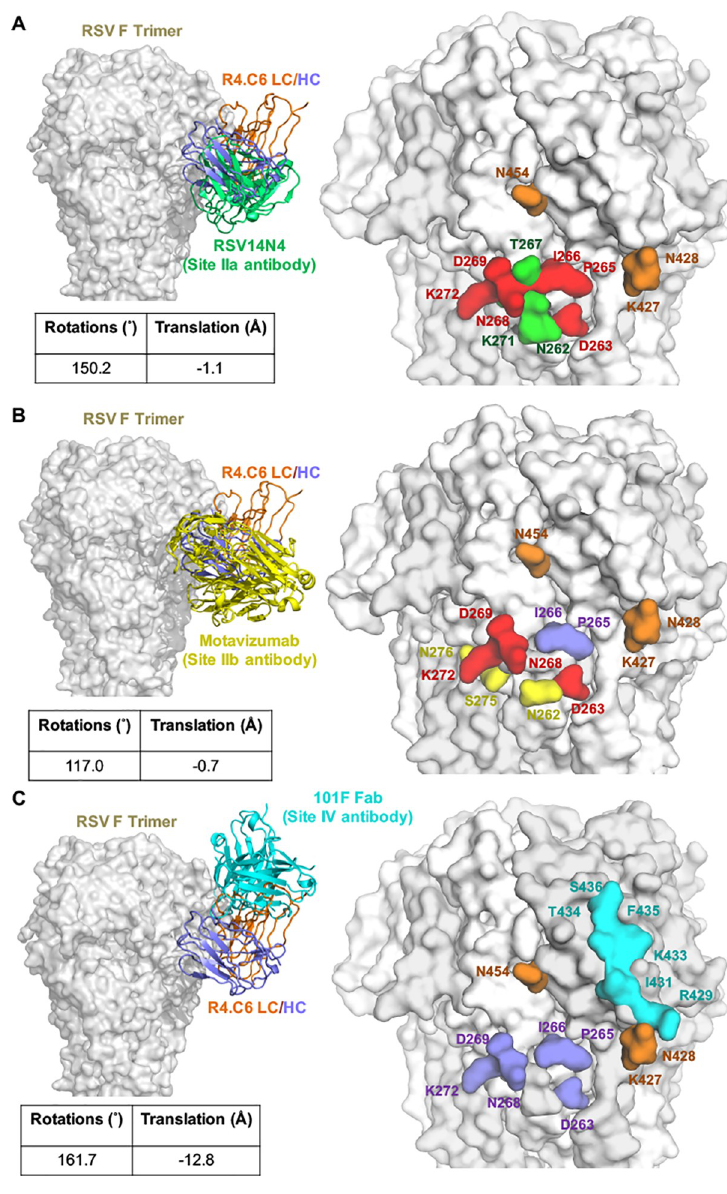
Fig 4. Comparison of known structures of post-fusion RSV F and site II or site IV antibodies. ( A) Comparison of the structure of RSV F-R4.C6 with RSV14N4 bound to site II of RSV F (PDB code 5J3D). Left: RSV F is shown as surface presentation, R4.C6 in ribbons presentation colored in orange (light chain) and blue (heavy chain), and RSV14N4 in ribbons colored in green. Right: Overlap of R4.C6 and RSV14N4 epitopes. Shared residues between the two epitopes are colored red. Unique residues for RSV14N4 are colored as green. (B) Comparison of the structure of RSV F-R4.C6 with motavizumab–site II peptide complex (PDB code 3IXT). Left: Motavizumab in ribbons colored in yellow. Right: Overlap of R4.C6 and motavizumab epitopes. Shared residues between the two epitopes are colored red. Unique residues for motavizumab are colored as yellow. (C) Comparison of the structure of RSV F-R4.C6 with Fab 101F–site IV peptide complex (PDB code 3O45). Left: Fab 101F is shown in ribbons colored in cyan. Right: Overlap of R4.C6 and Fab 101F epitopes. Unique residues at site IV for Fab 101F are colored as cyan. In all panels, unique residues for R4.C6 are colored as blue for site II and orange for site